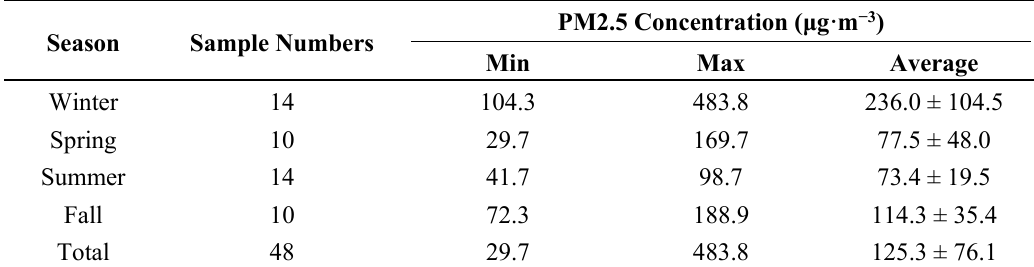
Table 2. PM2.5 concentrations of four seasons in Wanzhou.